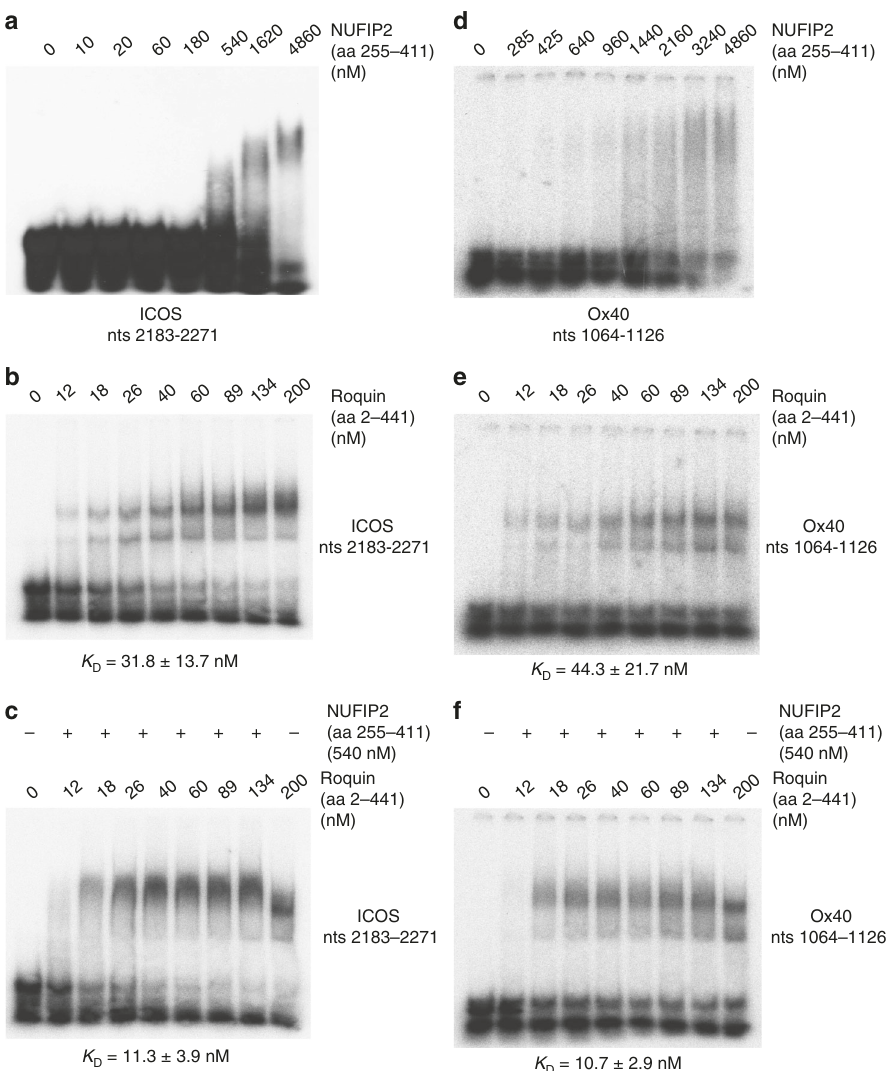
Fig. 8 Cooperative binding of NUFIP2 and Roquin to response elements in ICOS and Ox40 mRNA. a EMSA performed with the ICOS (nt 2183 – 2271) RNA ( a – c ) or Ox40 (nt 1064 – 1126) RNA ( d – f ) using increasing amounts (0 – 4860 n M ) of NUFIP2 (aa 255 – 411) ( a , d ) or increasing amounts (0 – 200 n M ) of Roquin-1 (aa 2 – 441) ( b , e ), or using increasing amounts (0 – 200 n M ) of Roquin-1 (aa 2 – 441) in the presence or absence of 540 n M NUFIP2 ( c , f